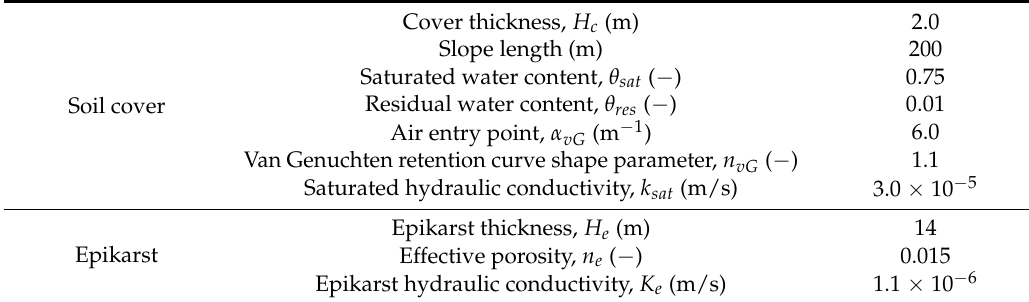
Table 4. Parameters of the coupled mathematical model of unsaturated soil cover and epikarst aquifer.